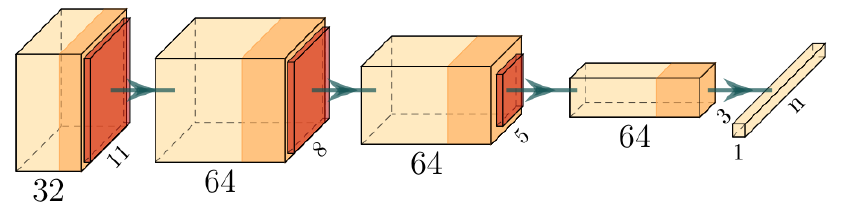
Figure 3. Pixelwise organ detection CNN